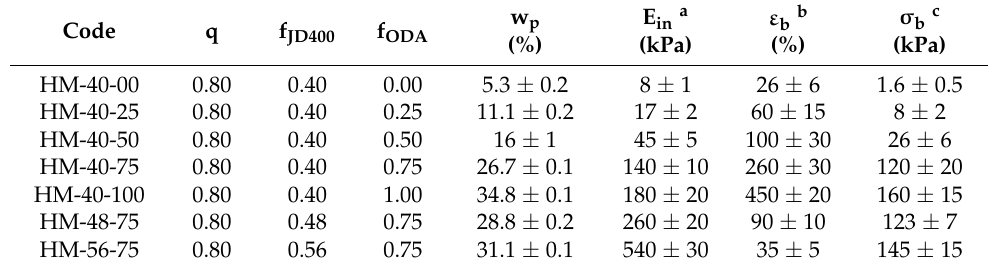
Table 4. Summary of the tensile properties of hydrogels equilibrated in 0.1 M NaCl (23 ◦